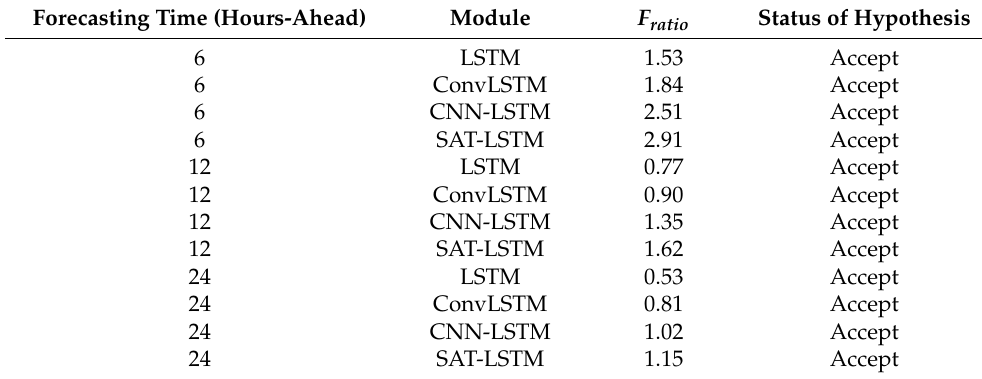
Table 4. The F-test for the proposed models. Forecasting Time